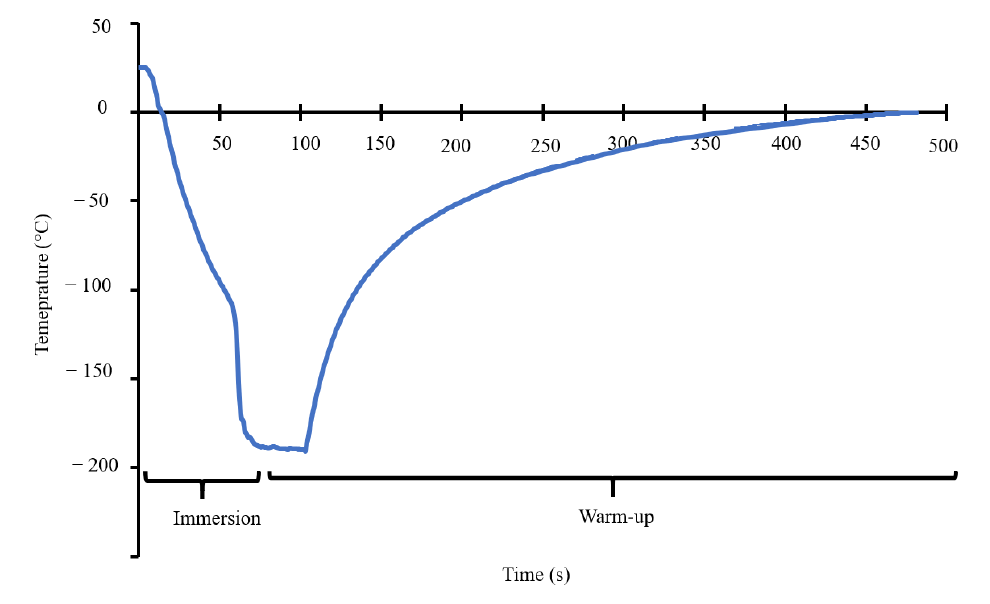
Figure 5. Temperature–time course during a cutting experiment; the sample was immersed in liquid nitrogen and then placed in the sample holder and the experiment was started once the given temperature was obtained; see main text for